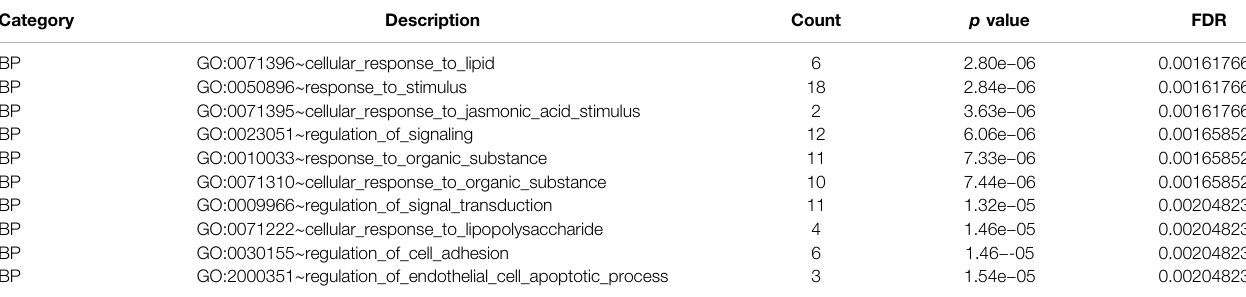
Category stands for GO terms and BP refers to biological